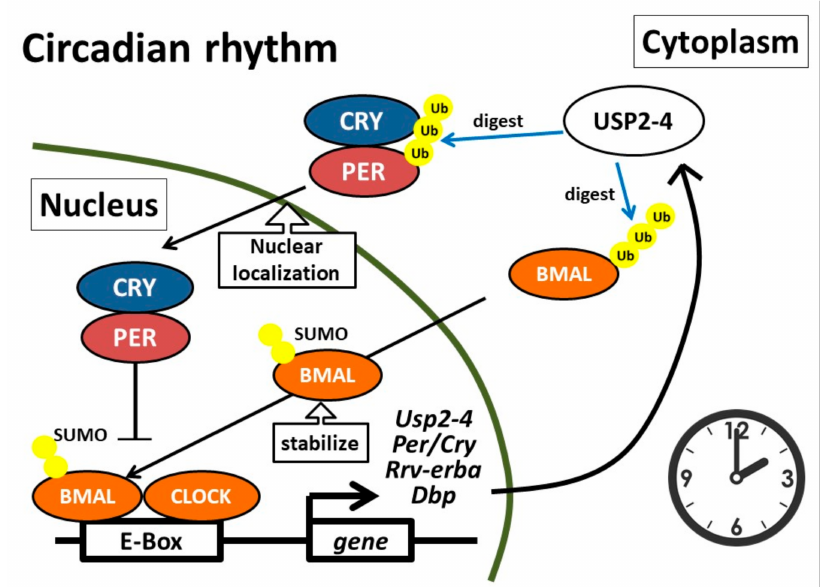
Figure 1. Roles of USP2-4 as a molecular clock regulator. USP2 is one of the known CLOCK/brain and muscle Amt-like protein 1 (BMAL1)-regulated molecules. One of the USP2 variants, USP2-4, digests the polyubiquitin chain on BMAL1, and subsequently promotes the accumulation of sumoy- lated BMAL-1 in the nucleus. Nuclear localization of BMAL1 leads to BMAL1/CLOCK-elicited gene expression. USP2-4 also digests the polyubiquitin chain on PER which results in prolonged nuclear localization of the PER1/cryptochromes (CRY) complex. CLOCK, Clock circadian regulator; PER,